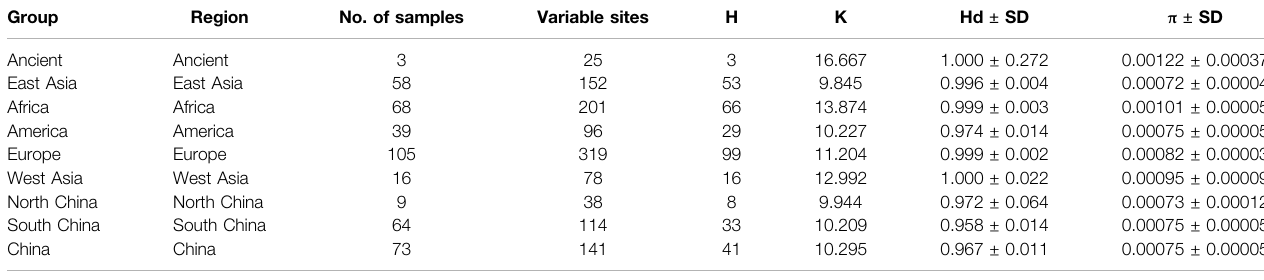
TABLE 2 | The haplotype and nucleotide diversity of T haplogroup cattle in dataset B. Group